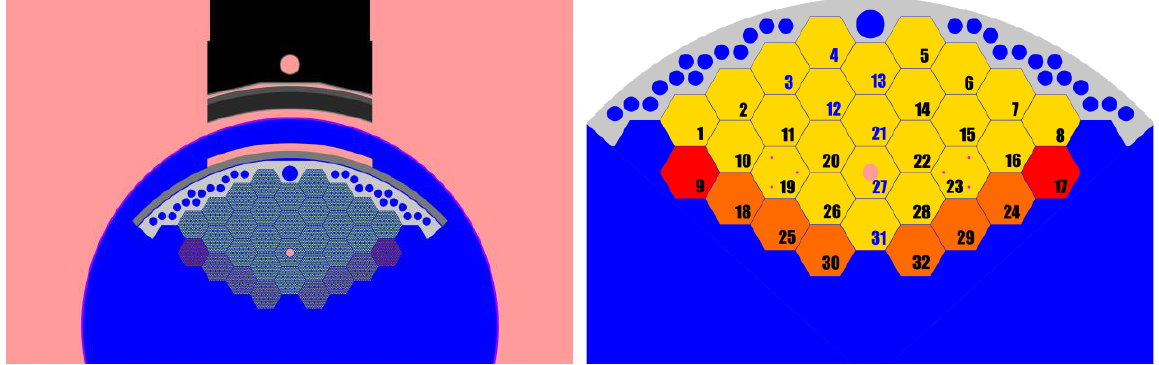
Figure 1. Radial arrangements of the VVER-1000 mock-up (left) and zoom on the mock-up core